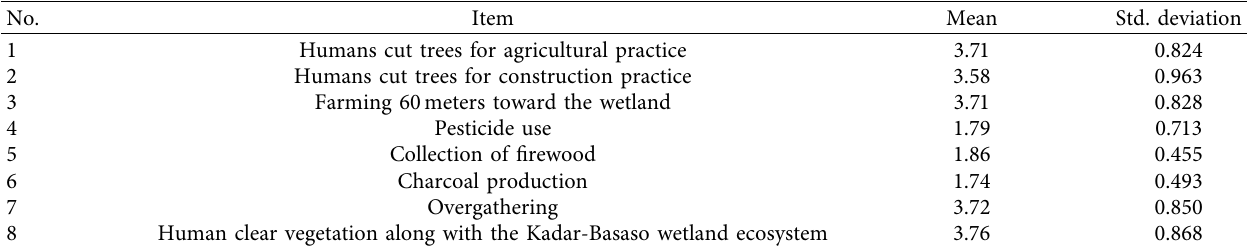
Table 5: Respondents’ view on the impacts of human activities on the Kadar-Basaso wetland ecosystem. No. Item Mean Std. deviation 1 Humans cut trees for agricultural